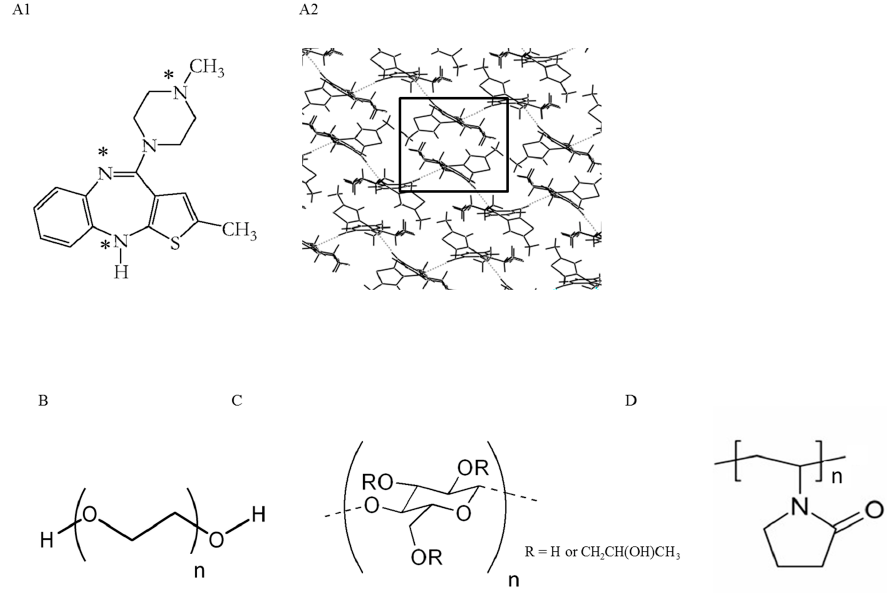
Figure 1. Olanzapine (OLZ) molecular structure ( A1 ) and molecular packing ( A2 ) of anhydrous OLZ FI and structures of PEGs ( B ); HPC ( C ) and PVPs ( D ). (*) Hydrogen bond acceptor or donor groups.